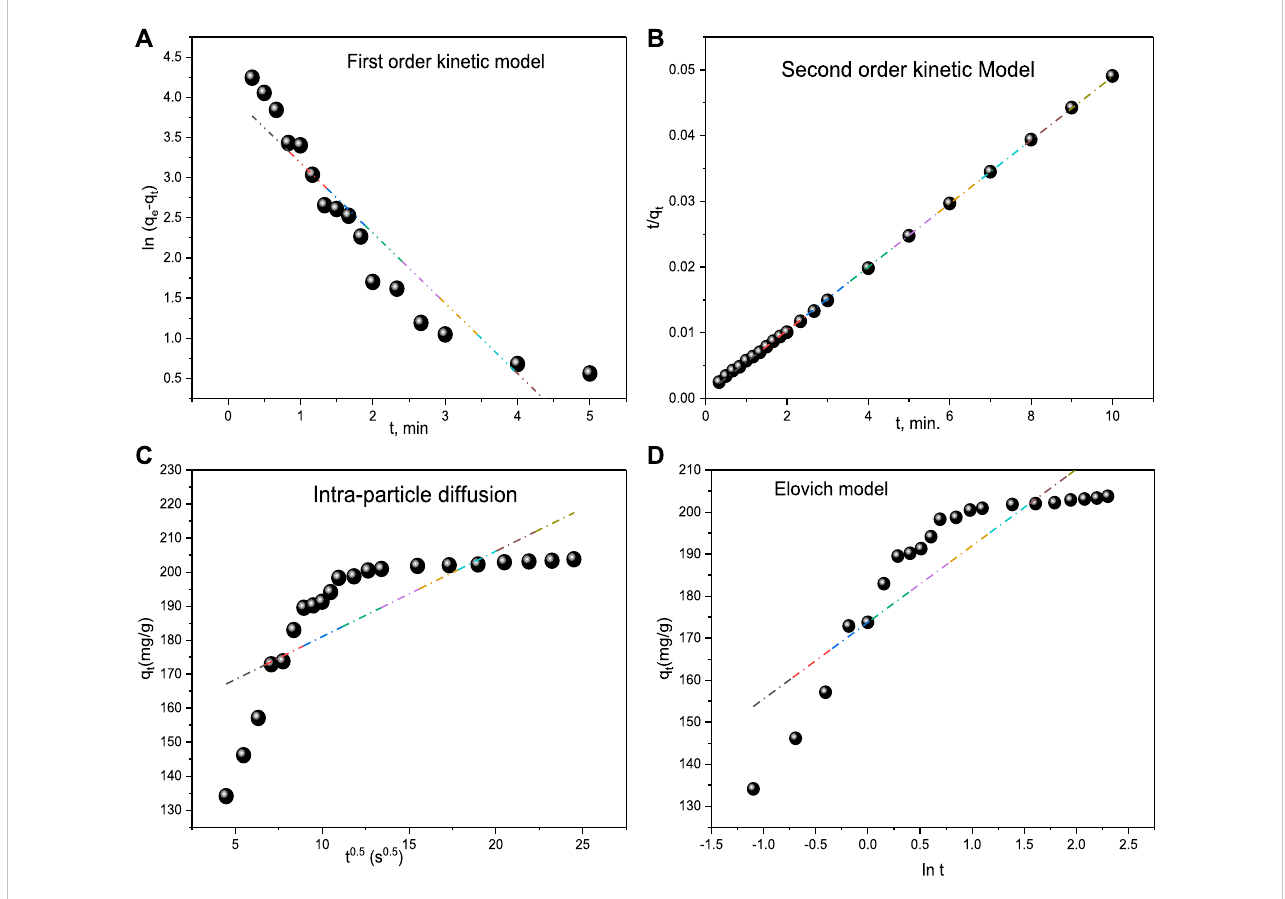
Kinetic models (A) First order kinetic model, (B) Second order kinetic model, (C) Intra-particle diffusion and (D) Elovich model for acid red 37 dye adsorption onto CM- β CD:nChi:Glu.